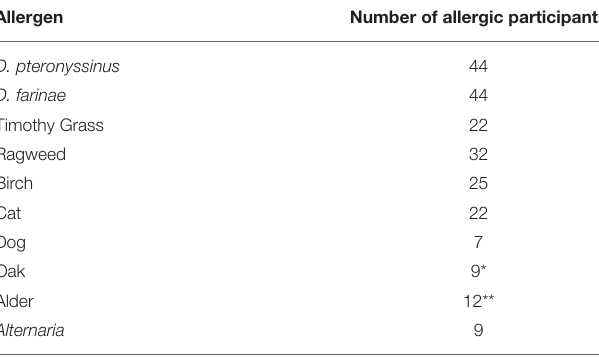
* Out of 25 participants. ** Out of 24